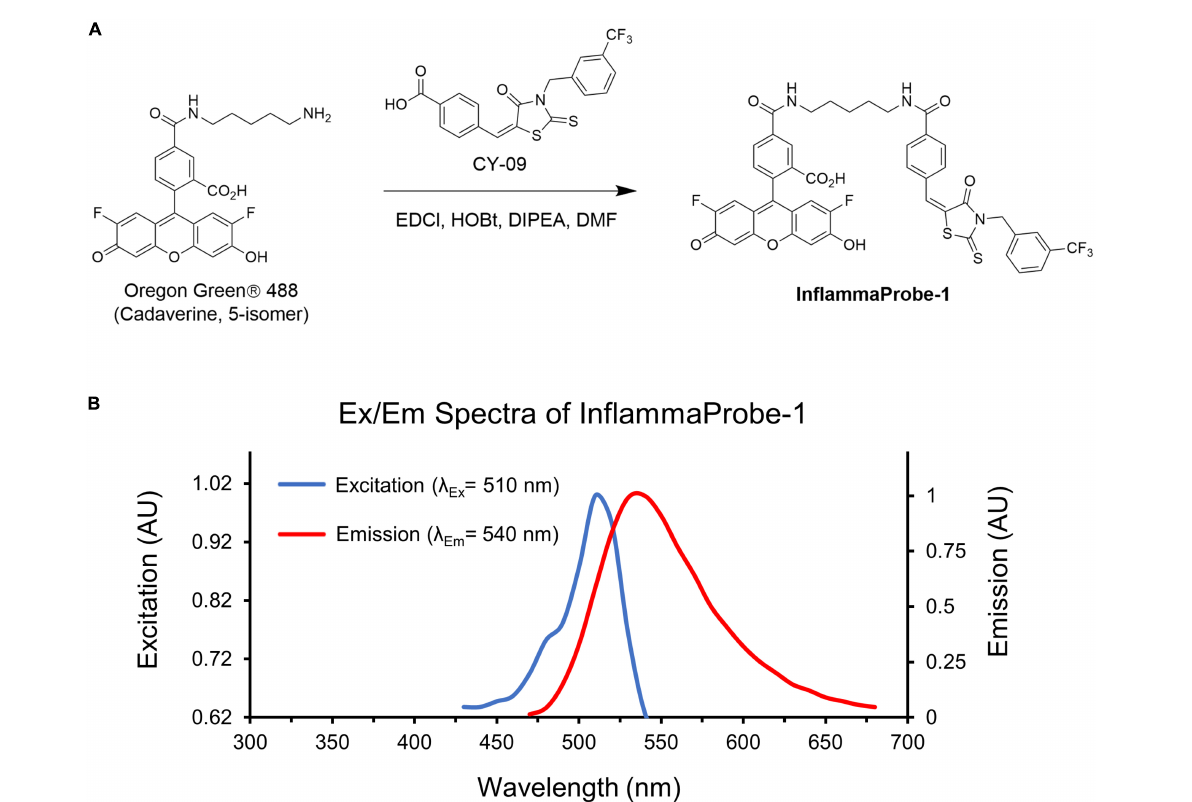
FIGURE1 Synthesis and characterization of InflammaProbe-1. (A) InflammaProbe-1 was synthesized by conjugating a selective inhibitor of NLRP3 (CY09) to a commercially available fluorophore (Oregon Green R (cid:13) 488). Conjugation was achieved with an EDCI-mediated coupling method. (B) Excitation and emission spectra of InflammaProbe-1 in ethanol containing 10%